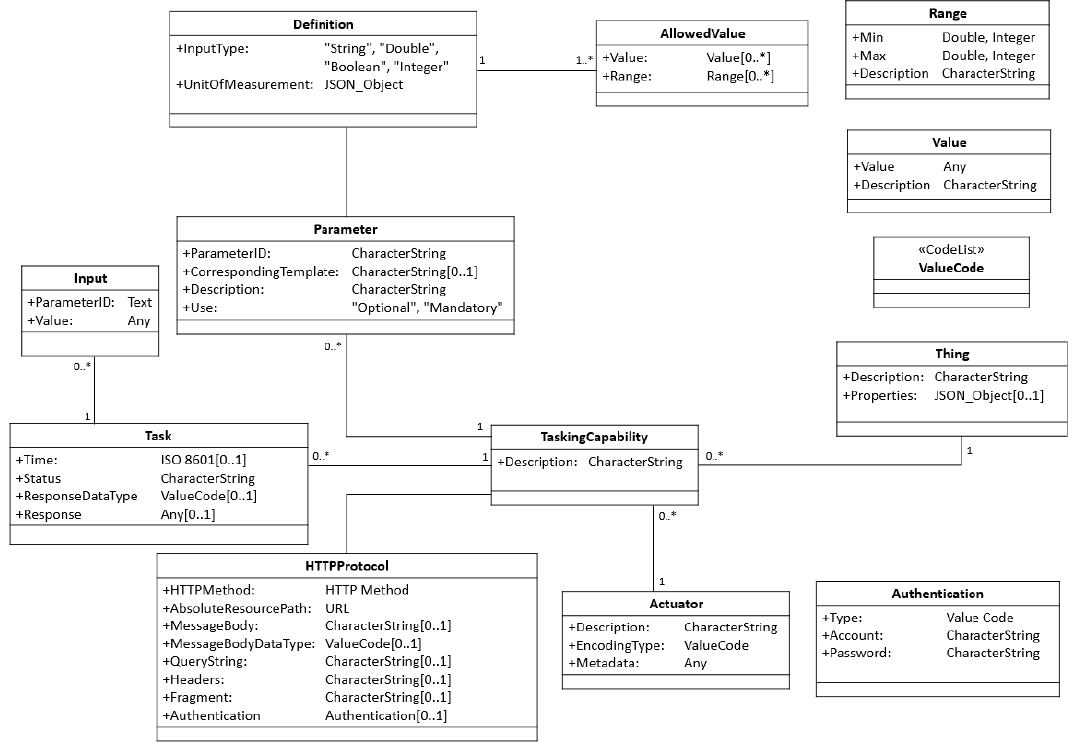
Figure 3. The data model of tasking capability [4].